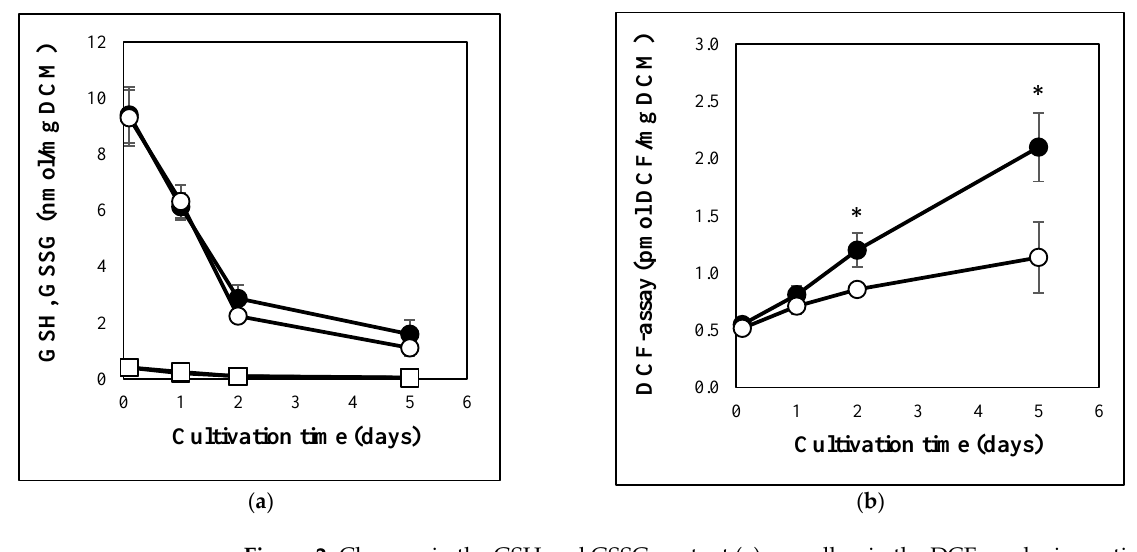
Figure 2. Changes in the GSH and GSSG content ( a ) as well as in the DCF producing activity ( b ) of carbon-limited and carbon-starved A. fumigatus cultures. Exponentially growing phase A. fumigatus Af293 cultures were resuspended in carbon-source-free minimal mediums either supplemented (carbon-limited cultures; for GSH and DCF-assay, (cid:3) for GSSG) or not (carbon-starved cultures; • for GSH and DCF-assay, (cid:4) for GSSG) with 4 g/L casein peptone. Mean ± SD calculated from three parallel experiments are presented. *—Significant differences between the mean values of the carbon-starved and carbon-limited cultures at the marked time point according to the Student’s t -test ( p < 0.05). Note, the GSSG levels of the two cultures were substantially not